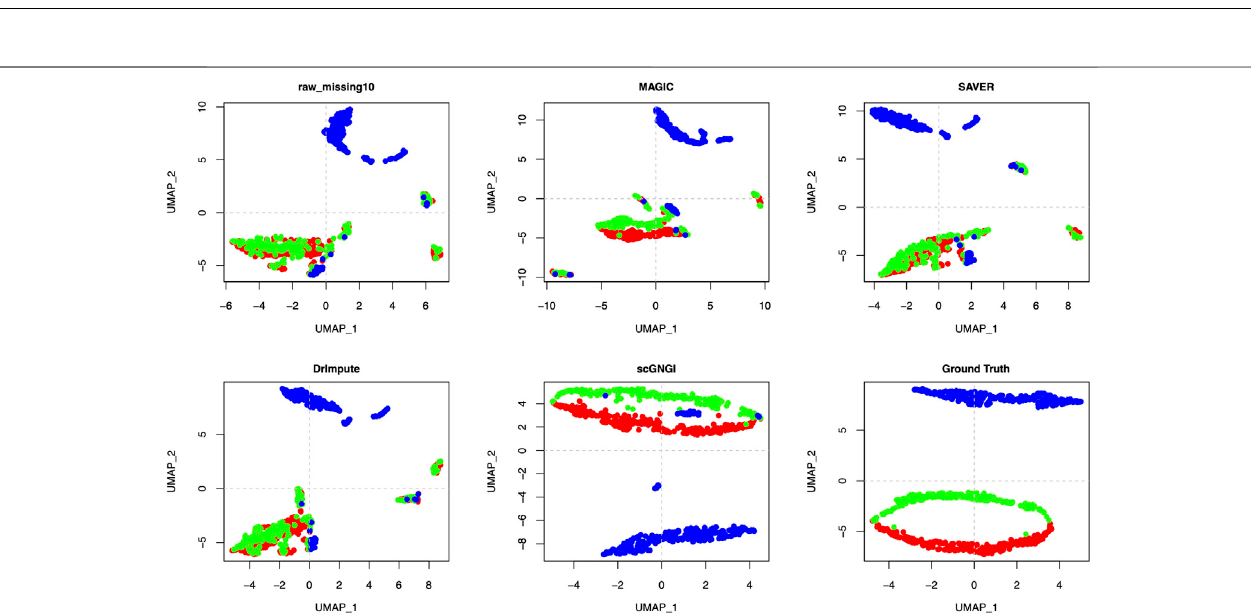
FIGURE5| ImputationperformanceontheSimulatedData3with3knowncelltypes. Visualizationofthecellsbythe fi rsttwoUMAPcomponents ontherawdata, missing data, and imputed ones by different methods. Each dot is a single cell, and different colors represent different cell types.